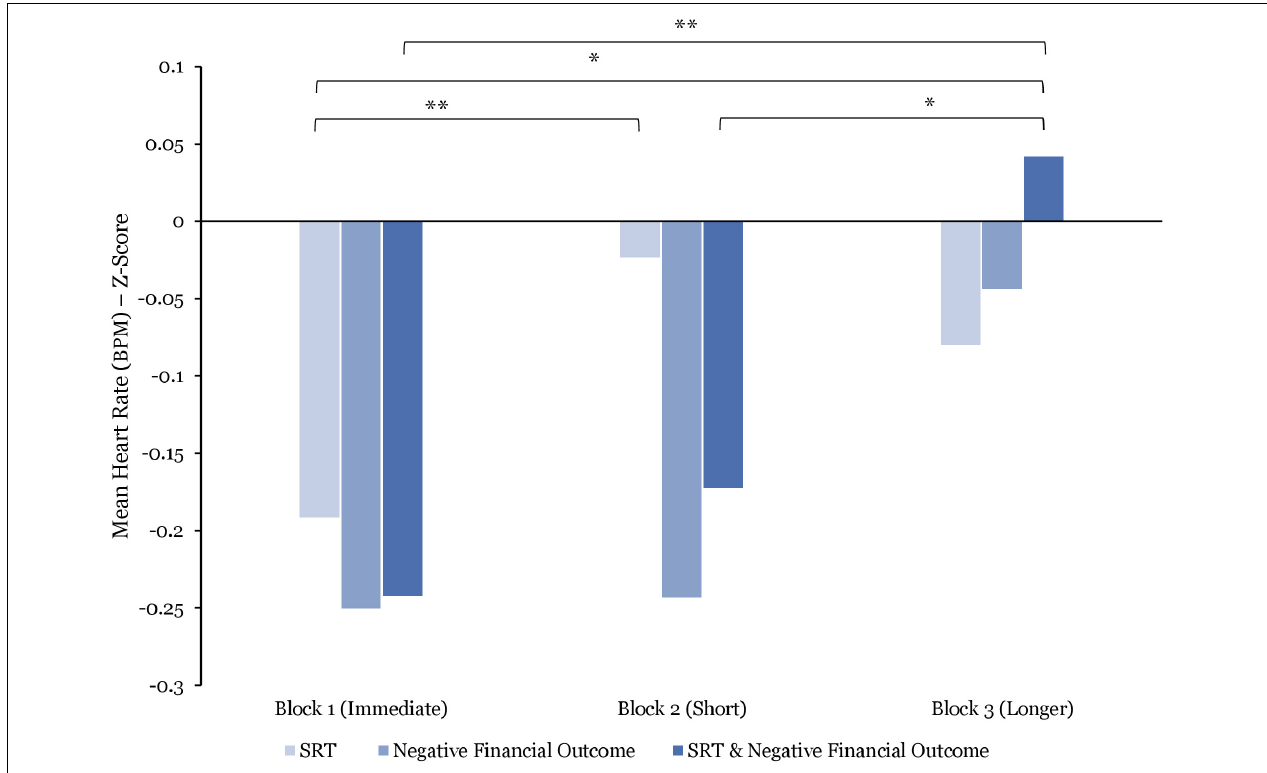
FIGURE 5 | Comparisons of mean heart rate (BPM) responses (z-score) by stress manipulations and by blocks. Significant differences are marked as ∗ p < 0.05; ∗∗ p < 0.01.